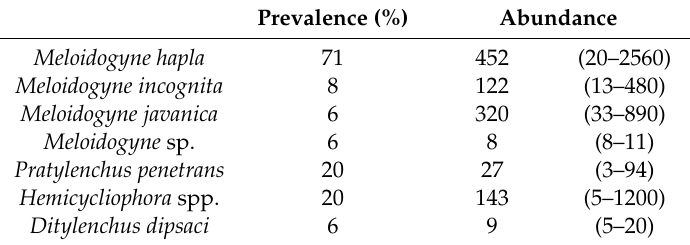
Table 3. Prevalence and abundance of plant-parasitic nematodes associated with strawberry crops in South